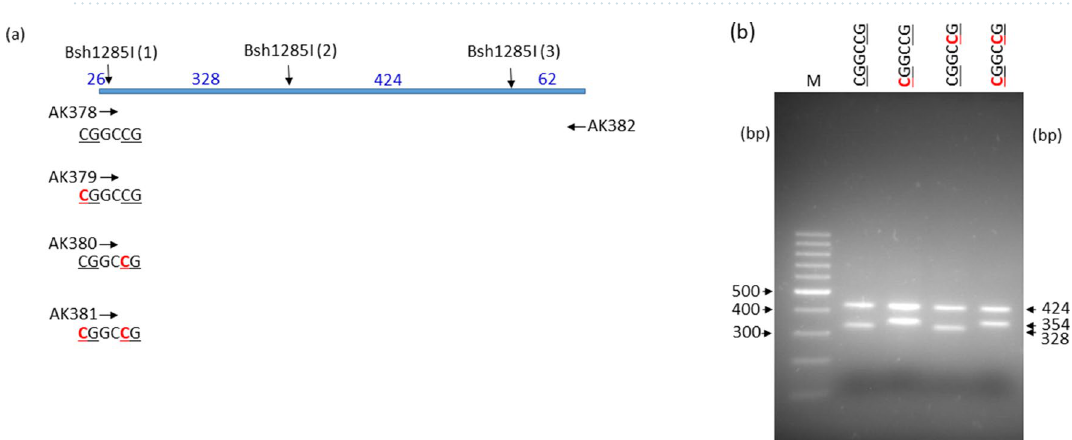
Figure 4. Targeted DNA methylation in E. coli by two dCas9-M.SssI variants. Cultures of E. coli ER1821 harboring pB-dCas9-L1-MSssI(wt)-T0+4 or pB-dCas9-L1-MSssI(Q147L)-T0+4 plus pOK-CRISPR-t-735 were induced with arabinose for dCas9-L1-M.SssI (wt or Q147L) expression. Plasmids prepared from the cultures were digested with Bsh1285I. ( a ) Map of pB-dCas9-L1-MSssI-T0+4 (wild-type and mutant) with Bsh1285I sites. The 6ZA and 6ZB zinc finger binding sites are shown by open and closed boxes, respectively. Red dashed circle, target region. Fragment sizes in base pairs are indicated with blue numbers. Methylation of the Bsh1285I 6672 site produces a 3261 bp (2428 + 833) protected fragment. ( b ) Time course of plasmid DNA methylation. Plasmids were prepared after different lengths of induction as indicated (in minutes) above the lanes. The samples contain digestion products of two plasmids. The two parental fragments and the resulting protected fragment are indicated by white circle and white asterisk, respectively. The fragments appearing first from off-target methylation are indicated by white x. M, GeneRuler 1 kb DNA ladder, Thermo Scientific. Cropped gels. Full- length gels are presented in Supplementary Fig. S10. Quantitative analysis of the relative amounts of the parental and the protected fragments is shown in Supplementary Fig. S11.